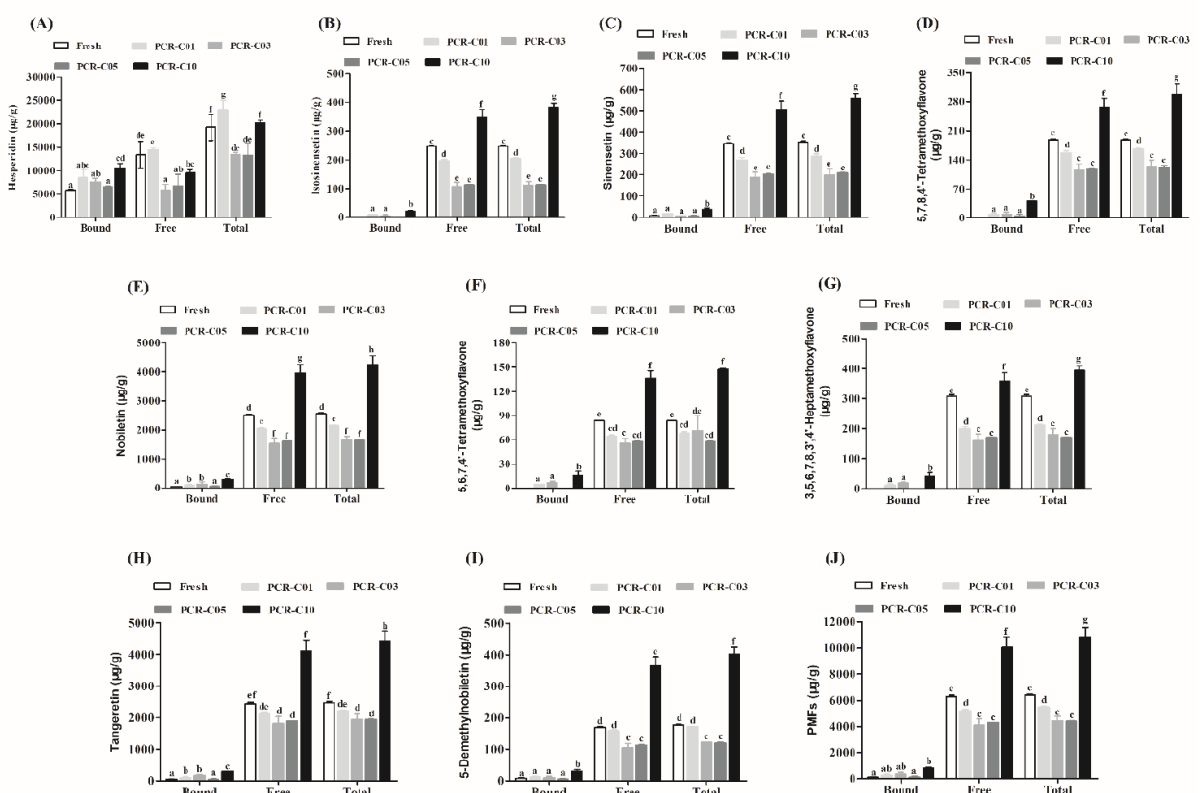
Figure 2. The variation of nine free, bound, and total flavonoids in PCR-C samples at different storage periods. ( A ) hesperidin, ( B ) isosinensetin, ( C ) sinensetin, ( D ) 5,7,8,4 (cid:48) -tetramethoxyflavone, ( E ) nobiletin, ( F ) 5,6,7,4 (cid:48) -tetramethoxyflavone, ( G ) 3,5,6,7,8,3 (cid:48) ,4 (cid:48) -heptamethoxyflavone, ( H ) tangeretin, ( I ) 5-demethylnobiletin, ( J ) PMFs. Data were expressed as the mean ± SD ( n = 3). Mean values with different letters in the figure indicate significant differences among PCR-C of different storage periods ( p <